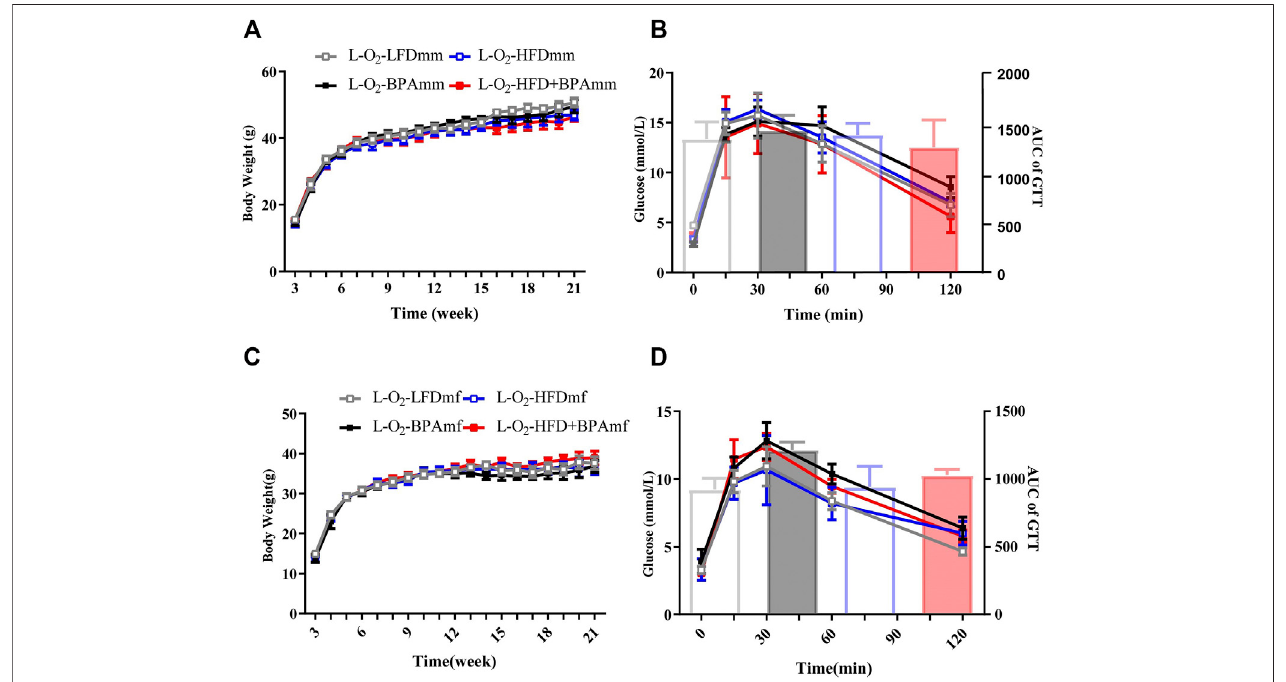
FIGURE 4 | HFD, BPA and their combination affect weight gain, glucose of patrilineal F2 with low fat diet. (A,B) Body weight and glucose tolerance of patrilineal male F2. (C,D) Body weight and glucose tolerance of patrilineal female F2. Data are mean ± SEM and were analyzed by two-way ANOVA with a posthoc test.